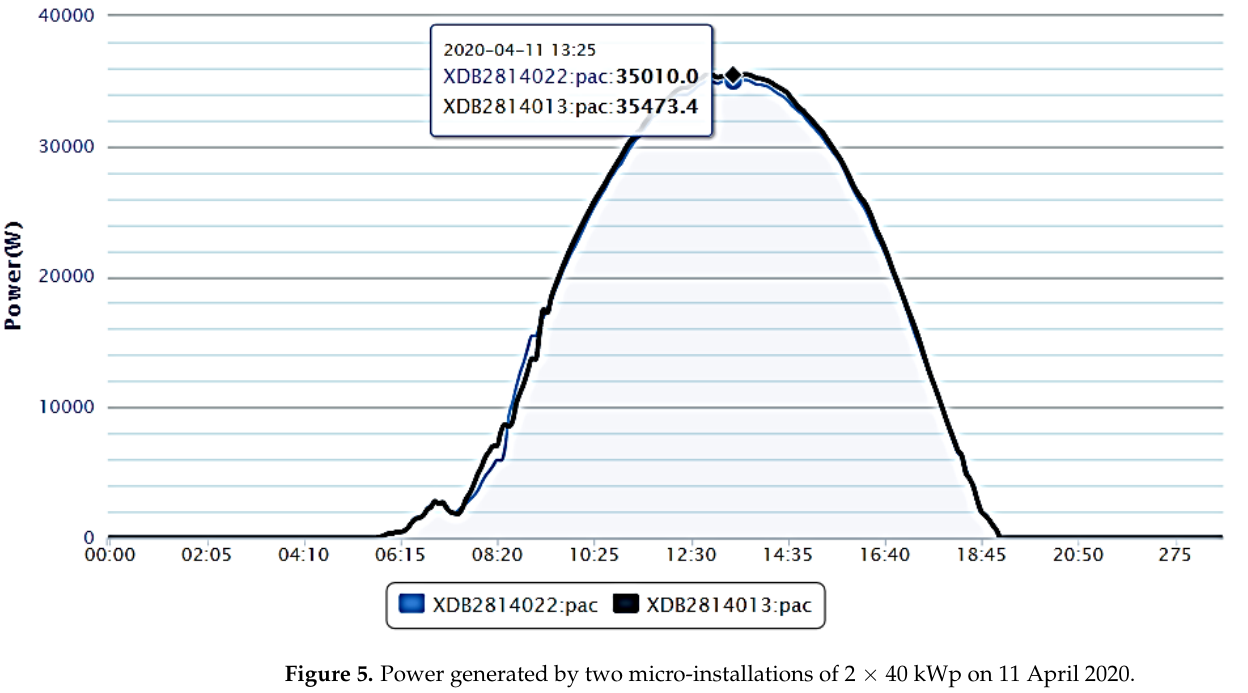
7 of 19 Figure 4. Total power generated by two micro-installations of 2 × 40 kWp per month (April 2020).